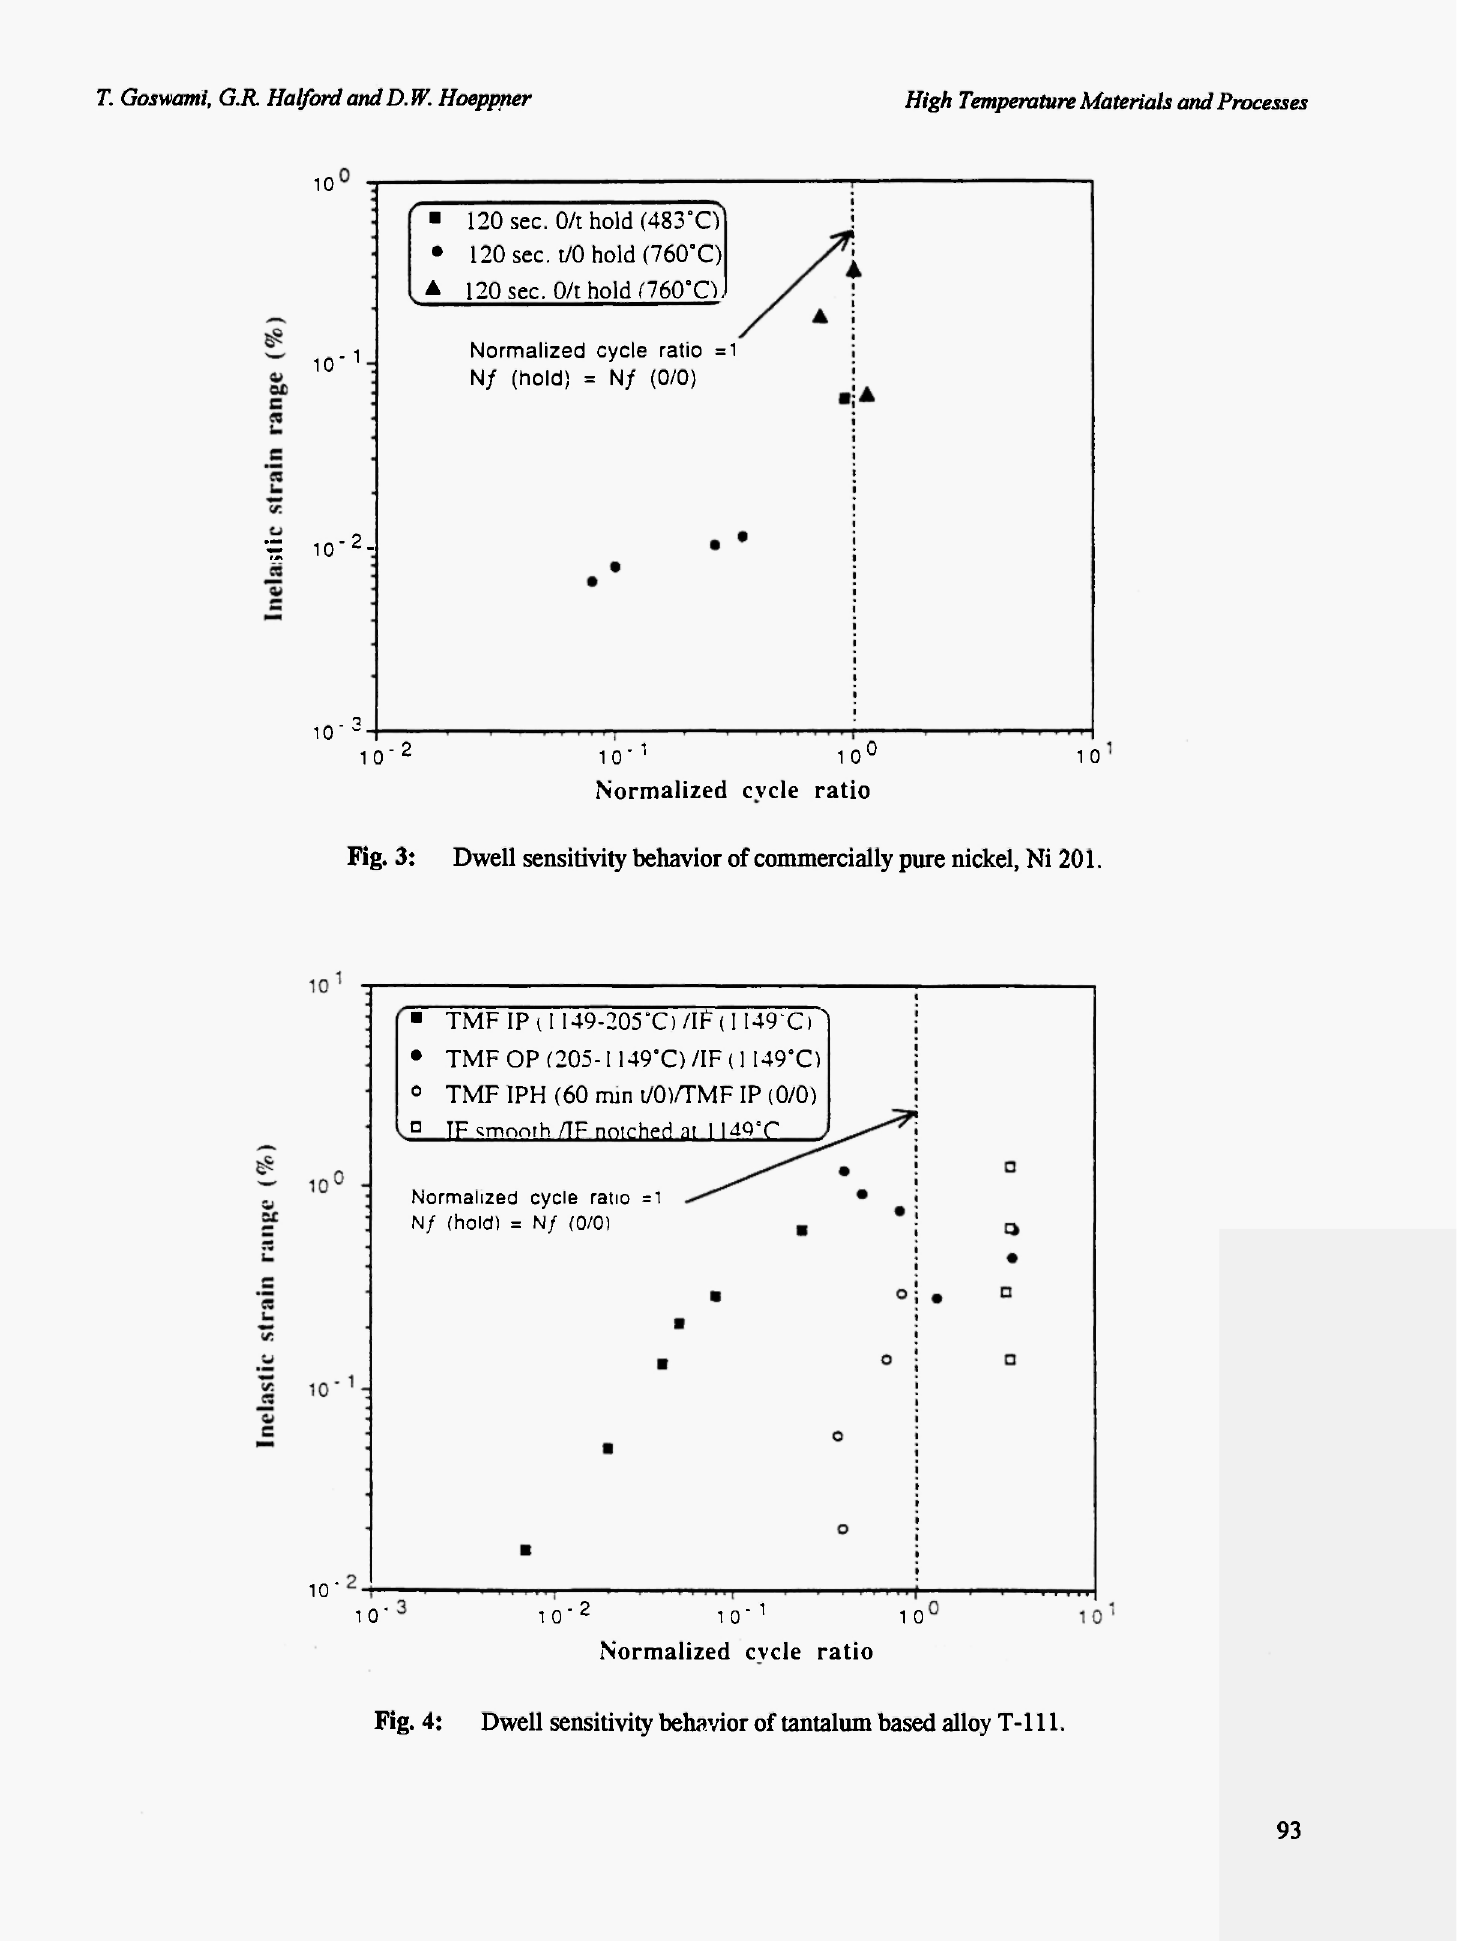
Fig. 4: Dwell sensitivity behavior of tantalum based alloy